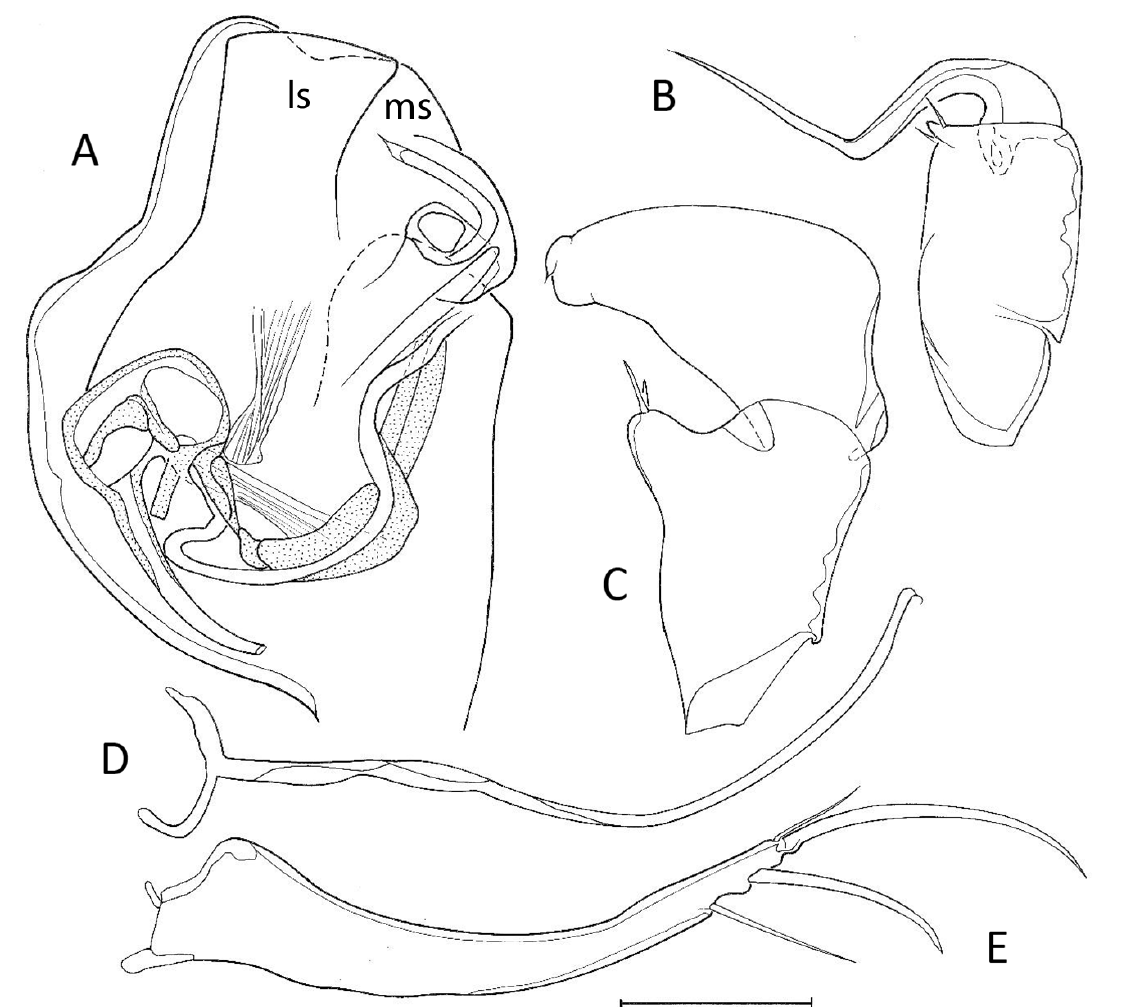
Fig. 9. Bilocypris fortescuensis gen. et sp. nov., ♂, holotype (WAM 67205), from Forstescue Marsh (type locality, sample PSW002). A . Hp. B . Lpp. C . Rpp. D . CR attachment (note: the bifurcation at the left side is the basis of the actual CR). E . CR. Scale = 92